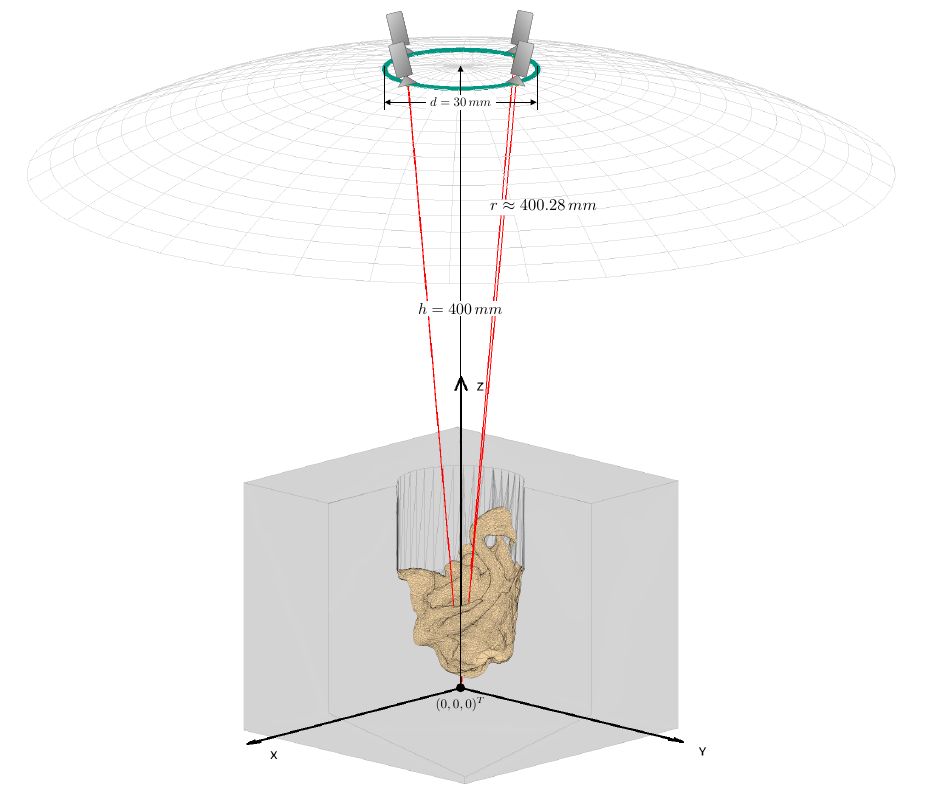
Figure 5. Schematic of the final camera setup model with an example mesh and four cameras. The mesh is centered at the origin of the world coordinate system. The cameras are placed on a ring (green) above the mesh. The wireframe hemisphere lies at a distance from the origin equal to the common main objective lens’ focal length. It marks the surface on which cameras may be positioned. The optical axes of the cameras are shown in red. The cameras all “look at” the central reference point, which is the origin in this case. The figure is not to scale in the z-direction. It has been shortened for illustration